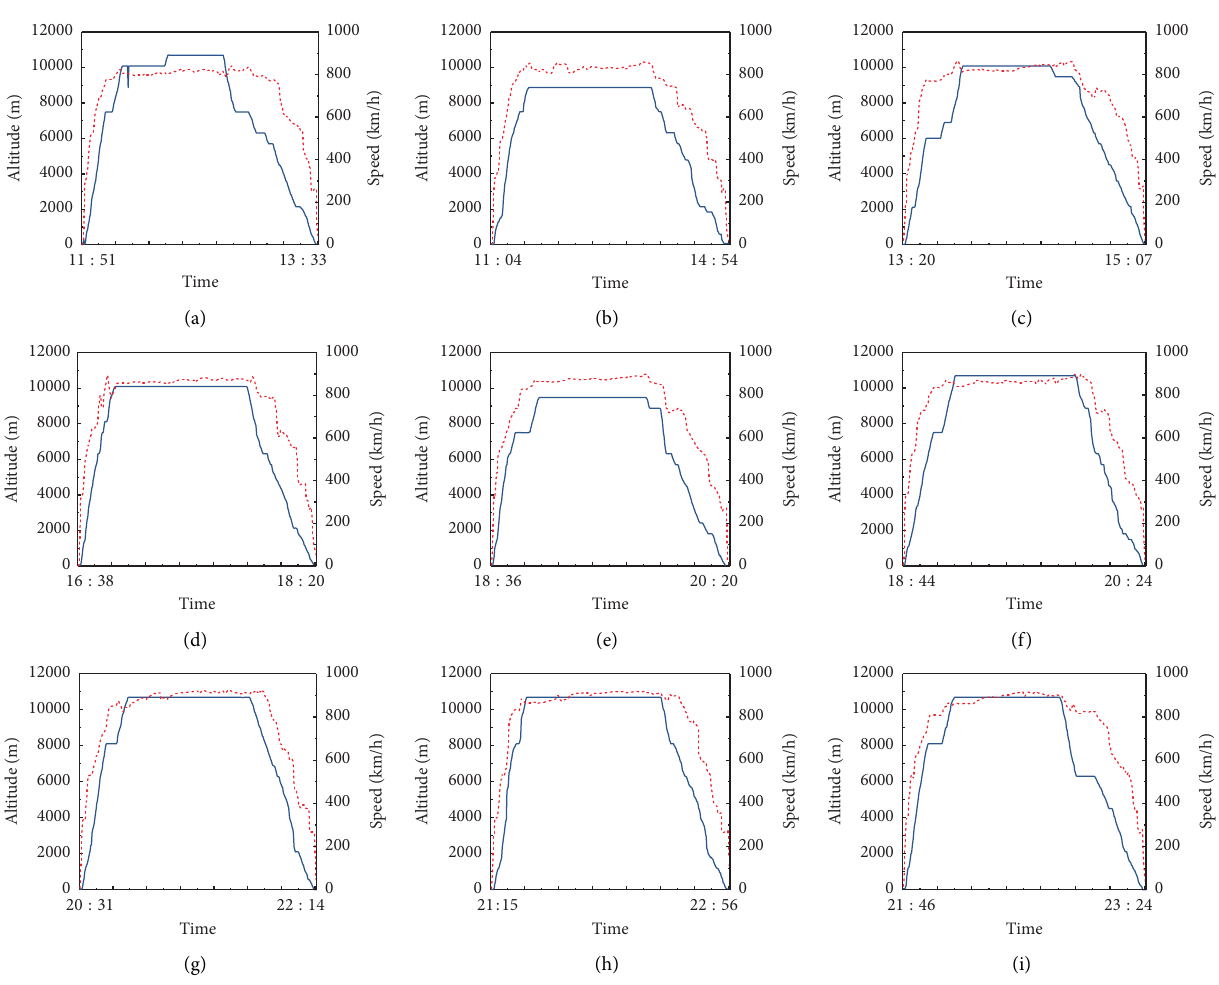
Figure 7: Operation durations and profile trajectories of the studied flights including (a) CCA1557, (b) CES515R, (c) CXA8178, (d)